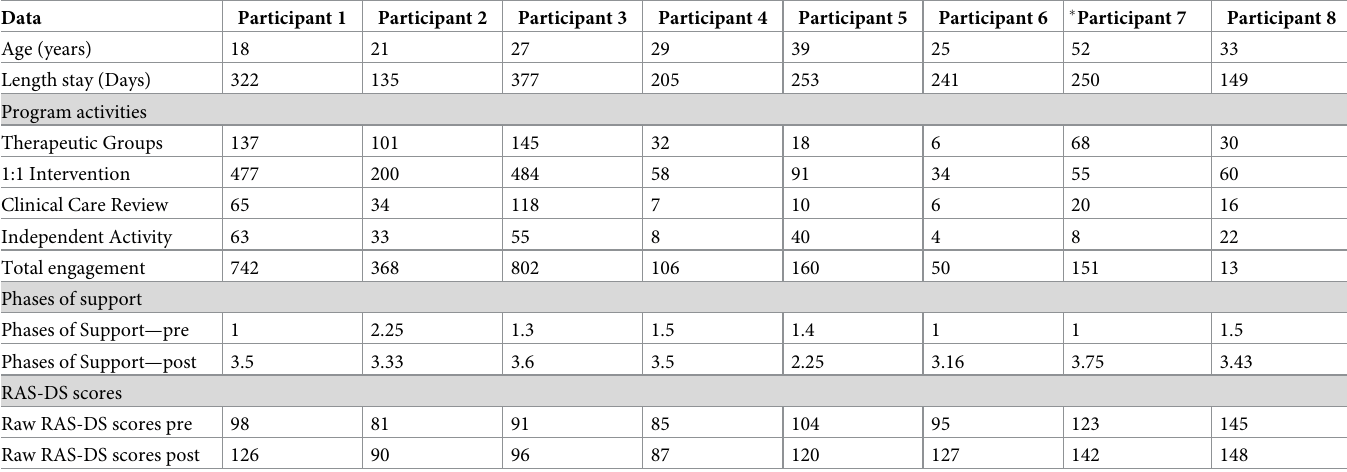
Table 2. Case note audit.